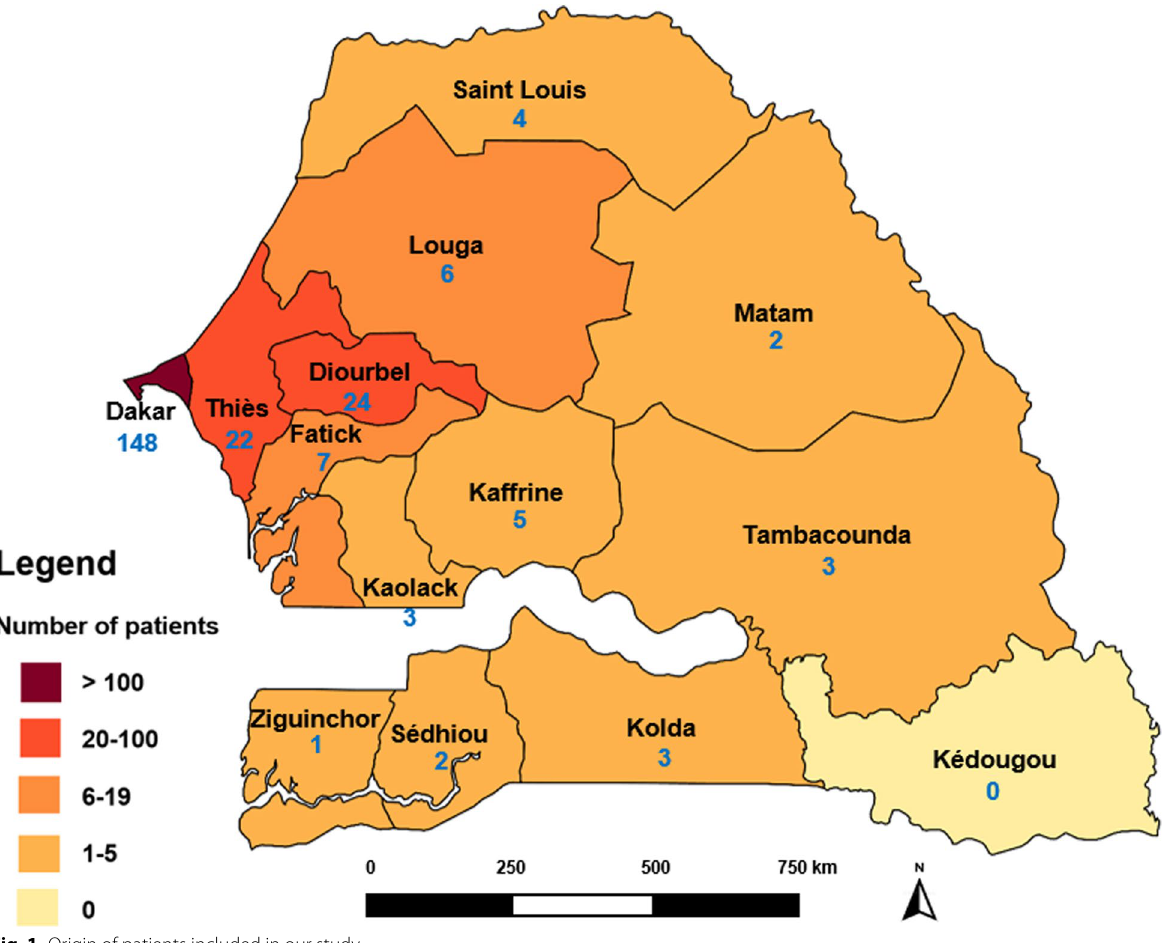
Fig. 1 Origin of patients included in our study